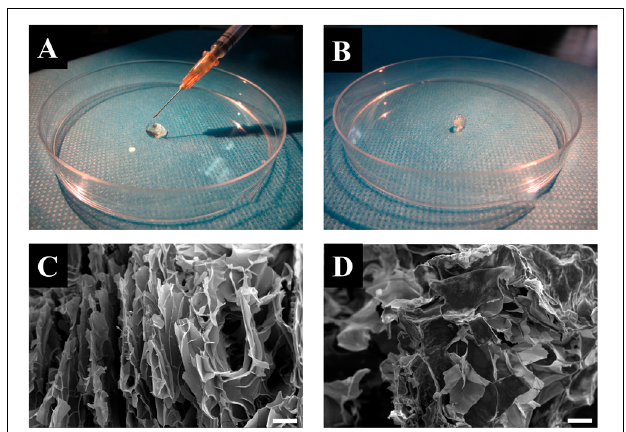
FIGURE 3 | (A) Injection operation of the CuS/HA hydrogel before gelation. (B) The gelated CuS/HA hydrogel. (C) SEM image of a cross-section of CuS/HA hydrogel, scale bar 100 µ m. (D) SEM image of a cross-section of HA hydrogel, scale bar 100 µ